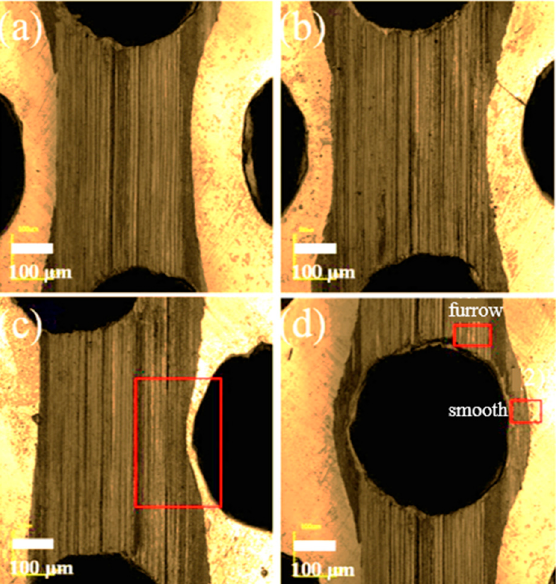
Figure 11. Image of the wear track under ( a , c ) the load of 2 N, ( b , d ) the load of 5 N, and the sliding speed of 0.5 Hz.